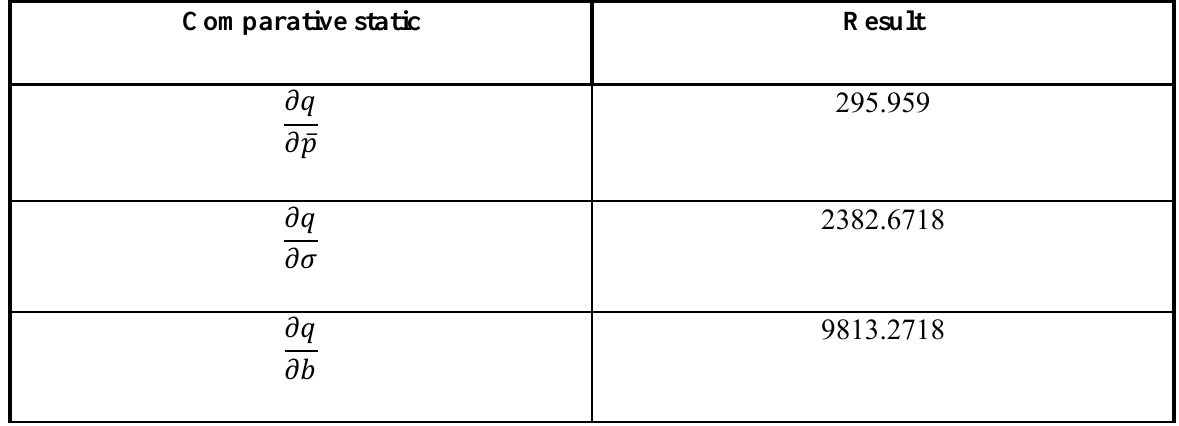
Table 3. Comparative Statics Results for